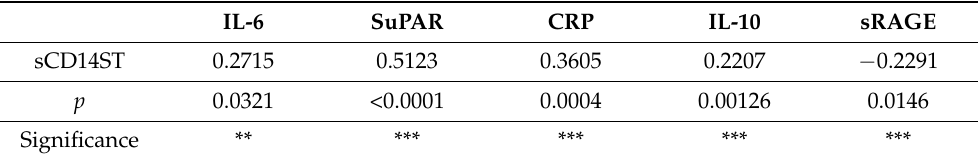
Table 3. Correlation (Spearman r, 95% confidence interval) of SCD14-ST with the other inflamma- tory biomarkers and the severity scores analyzed in the study. (** = p < 0.01 very significative, *** = p < 0.001 extremely